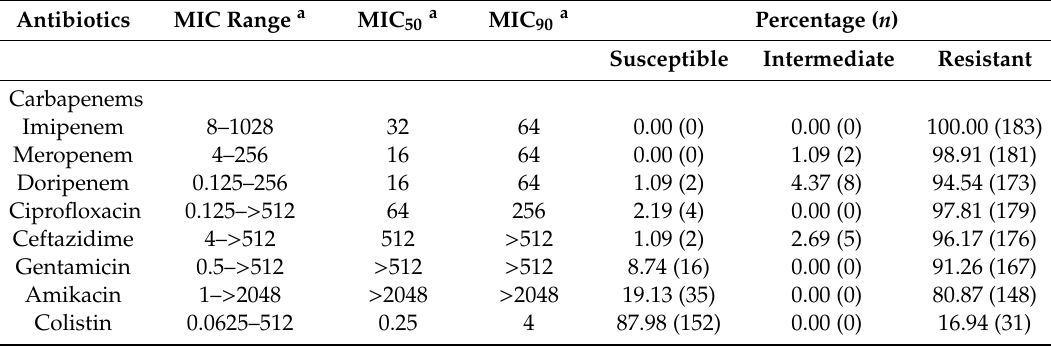
Figure 1. Antimicrobial susceptibility pattern of carbapenem-resistant A. baumannii isolates in Thailand. IMI: imipenem; MER: meropenem; DOR: doripenem; AMK: amikacin; GEN: gentamicin; CIP: ciprofloxacin; CTZ: ceftazidime; COL: colistin. Table 2. The antimicrobial susceptibility results for all 183 carbapenem-resistant A. baumannii (CRAB)